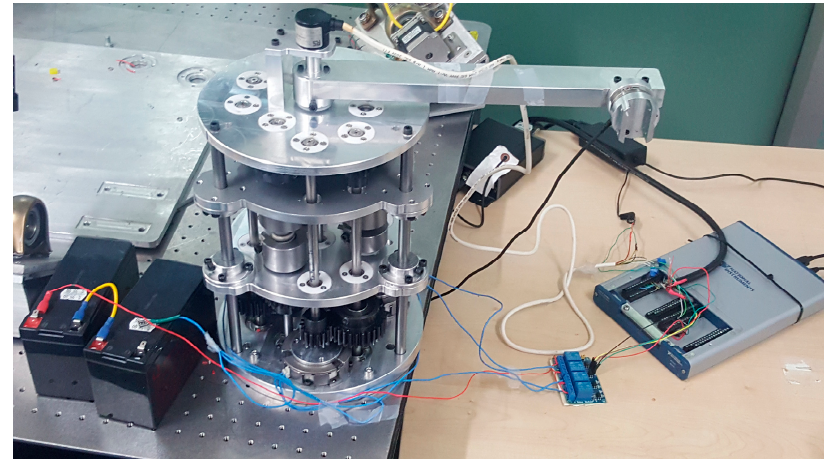
Figure 1. The passive version of the discrete variable stiffness actuator (DVSA)